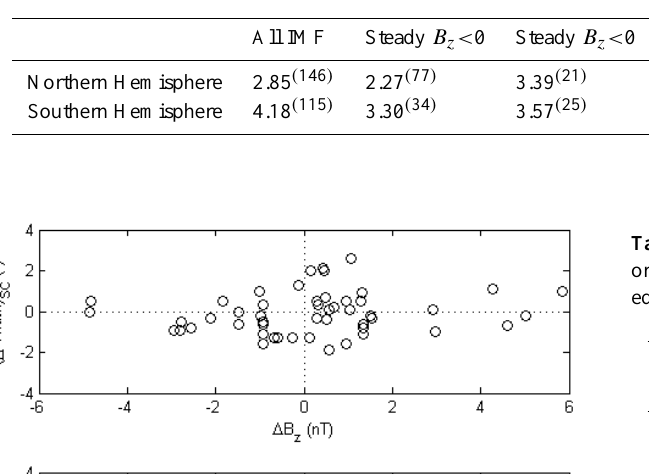
Table 1. : Cusp width in thousands of km for both hemispheres as a function of the IMF behavior.